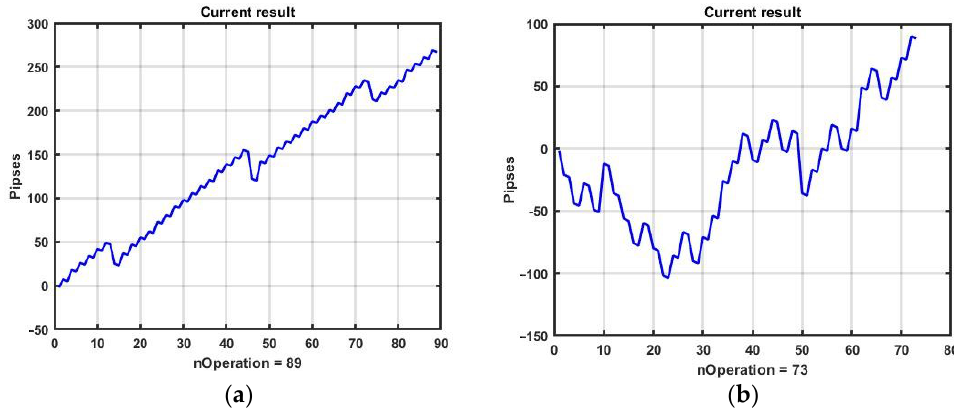
Figure 17. Performance of optimized control after applying the CSB strategy in the observation